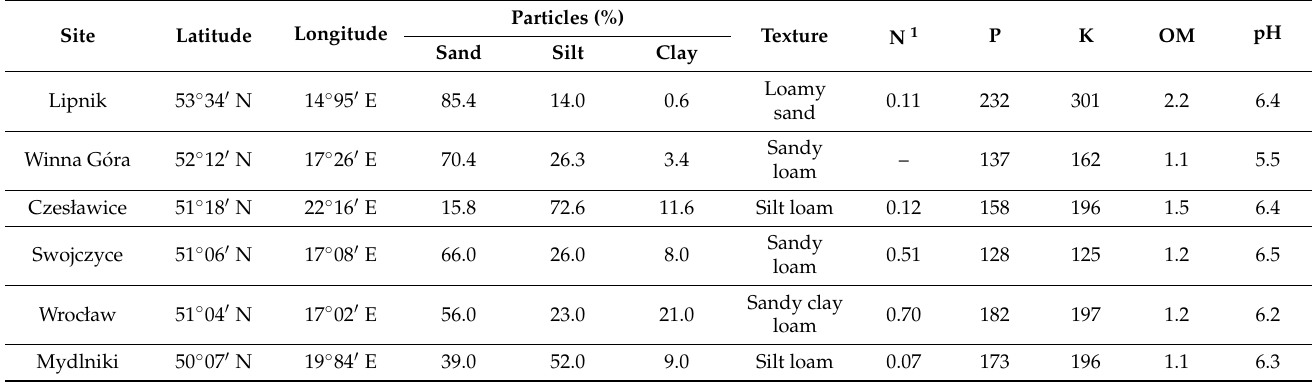
Table 2. Coordinates and soil physical and chemical properties of the study